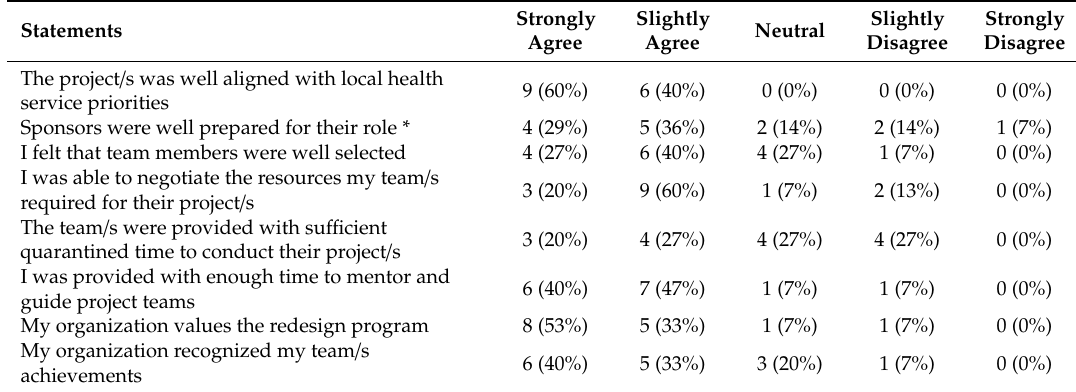
Table 3. Perceptions of expert coaches regarding organizational support ( N = 15).